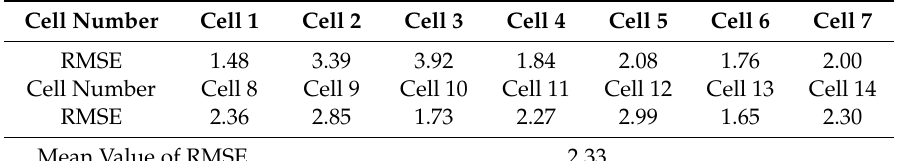
Table 4. RMSE of synchronous state